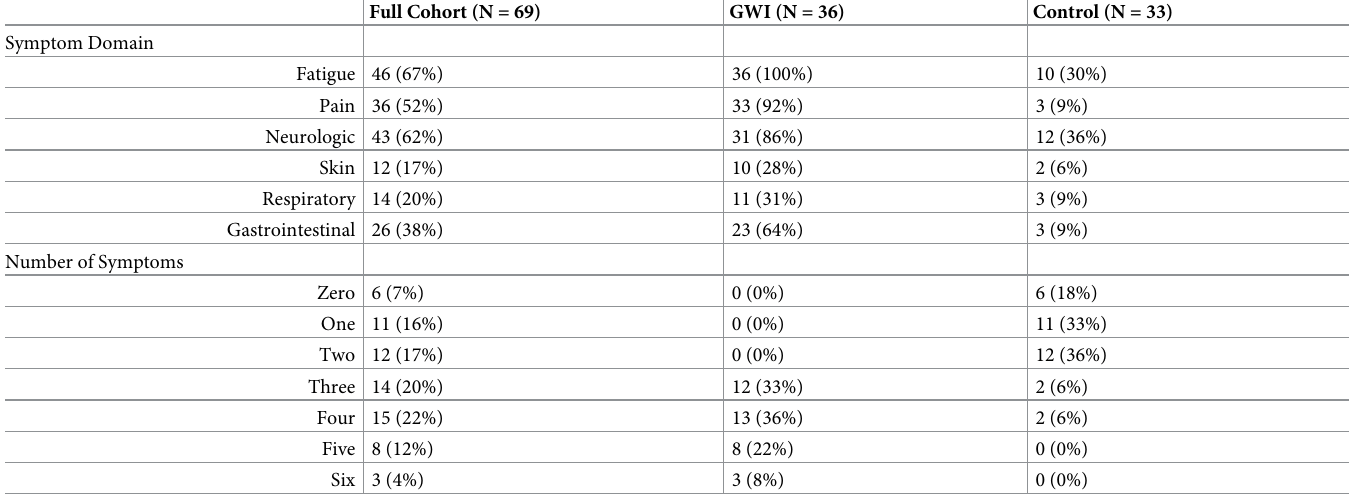
Table 3. Reported moderate/severe symptoms and GWI domain by